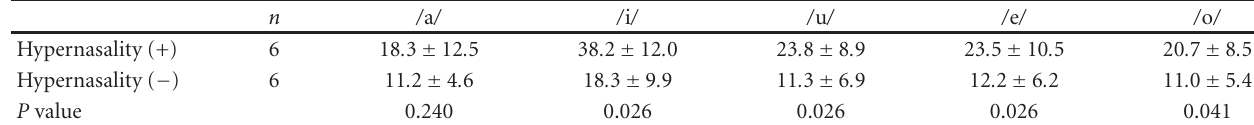
Table 3: Nasalance scores (NSs).